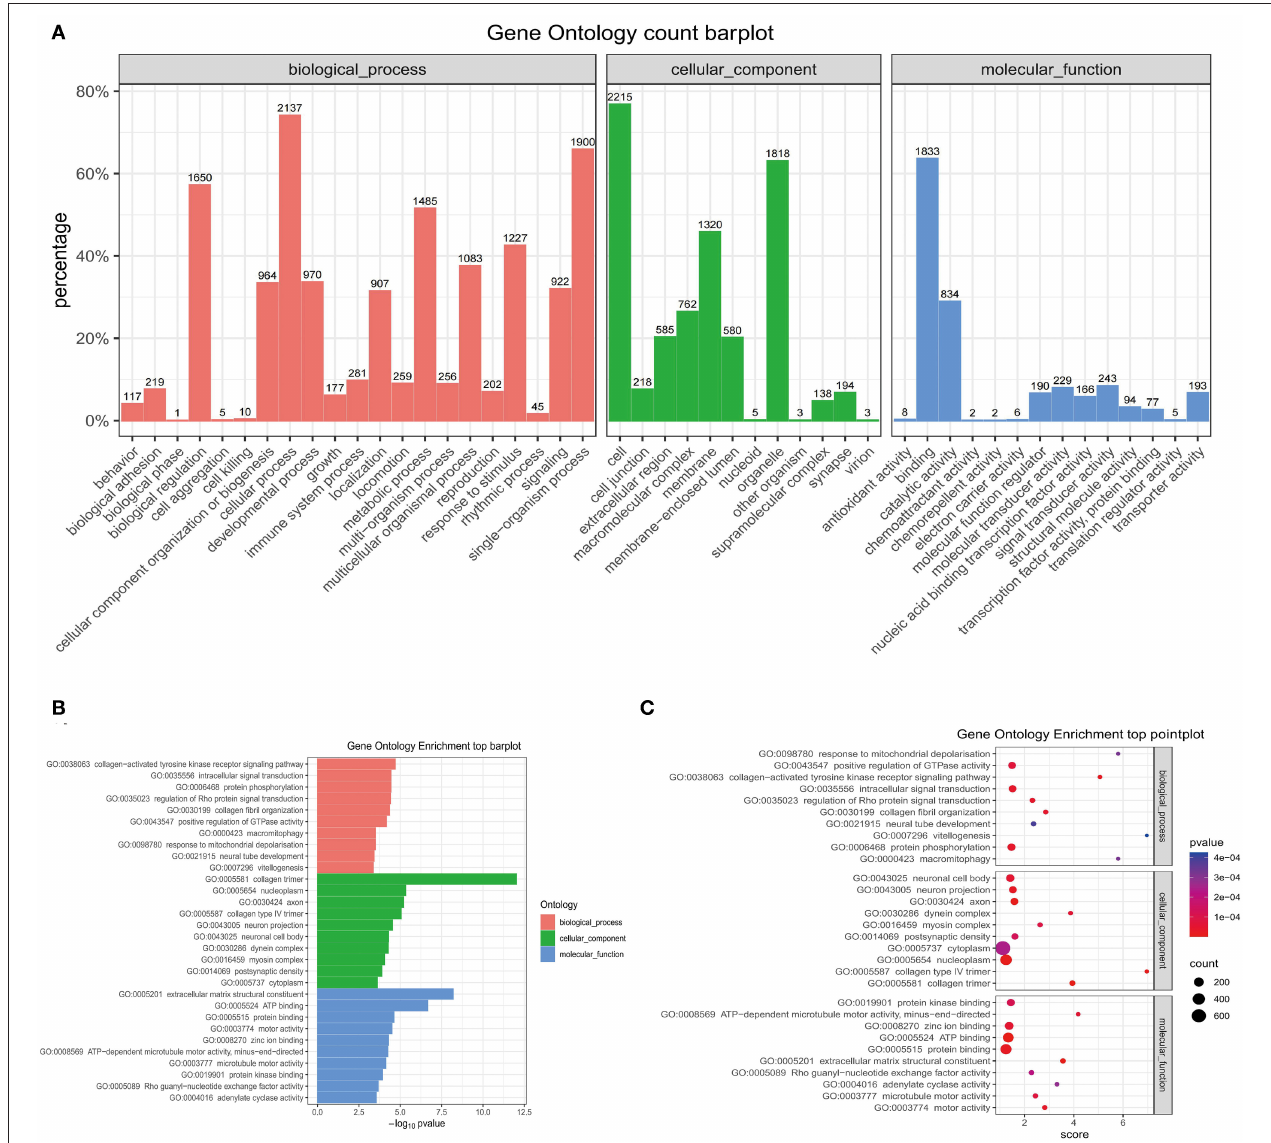
FIGURE 9 | The GO enrichment analysis. (A) The barplot of the GO count. (B) The barplot of top enrichment in the biological process, cellular component, and molecular function. (C) The pointplot of top enrichment in biological process, cellular component, and molecular function. GO, Gene Ontology.